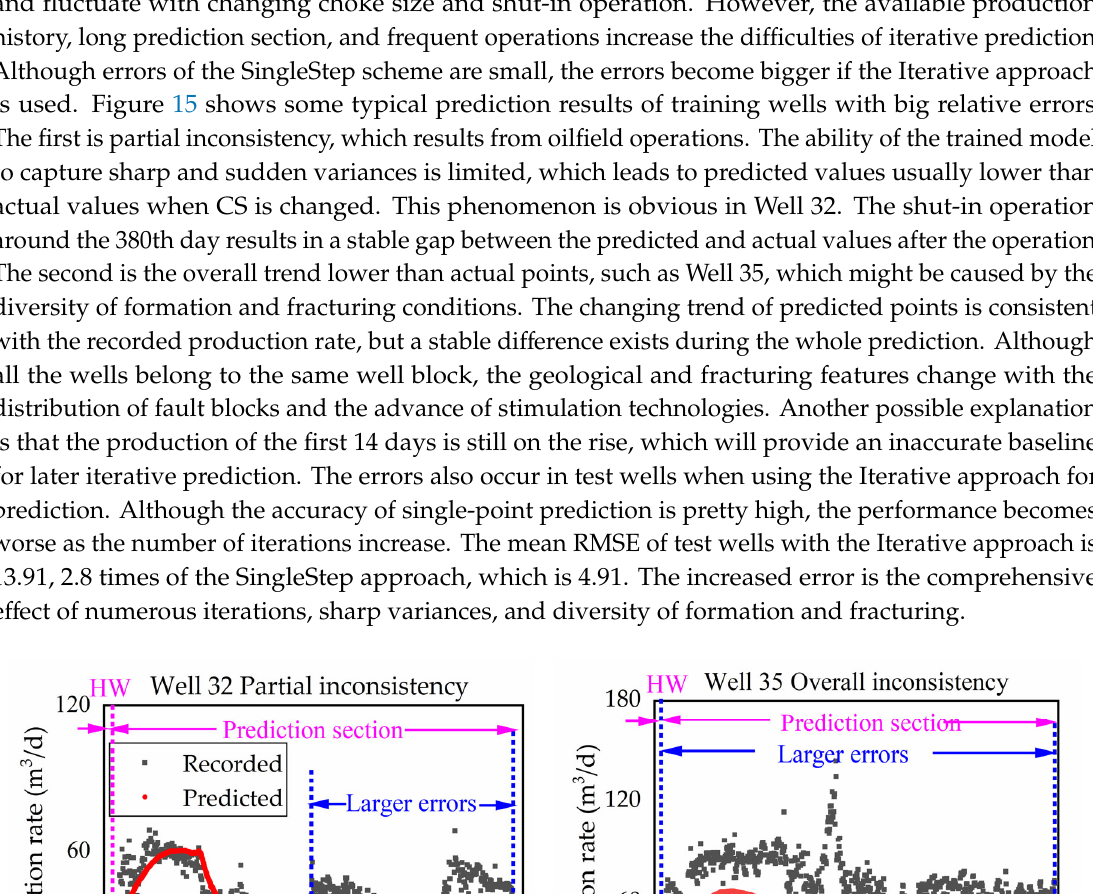
Table 3. The input and output features of the Random Forest (RF) model.